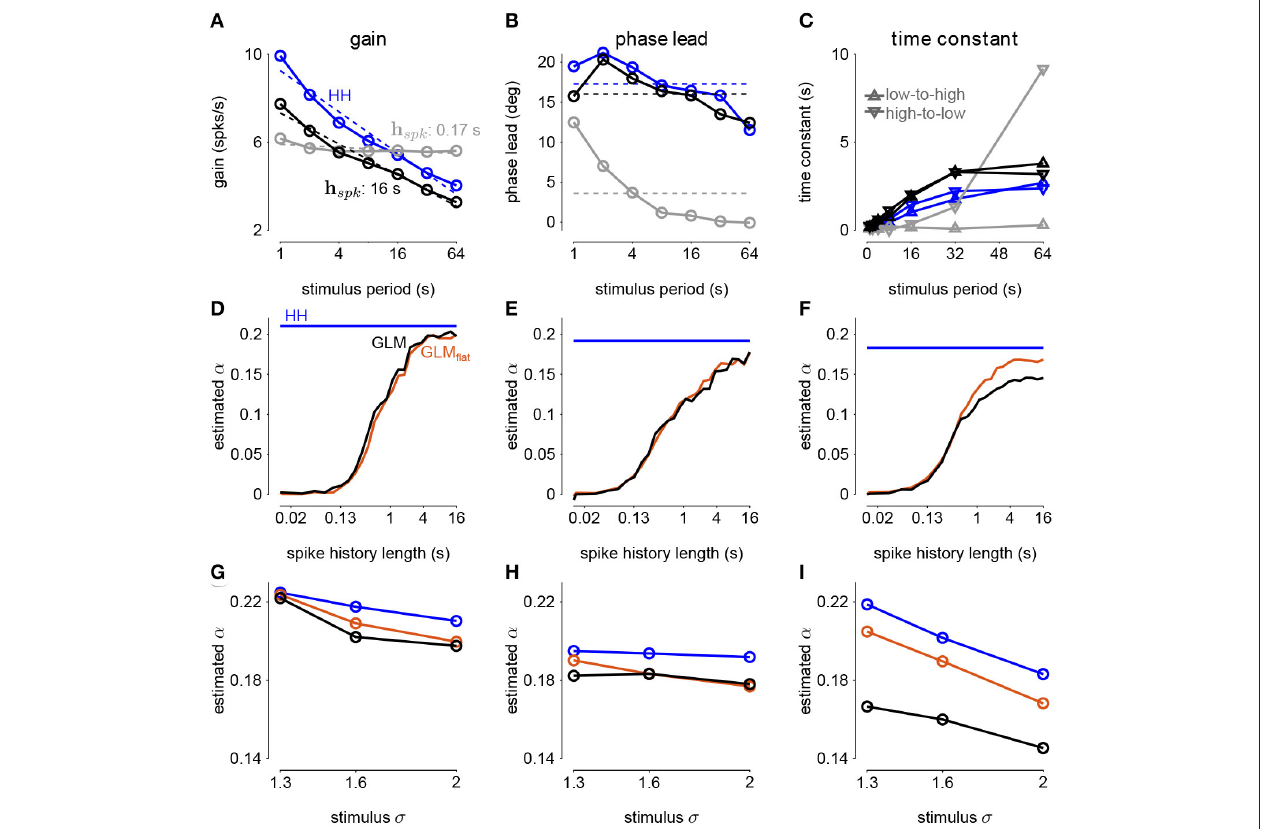
FIGURE 9 | (A) The gain of the average responses to sine-wave modulated noise as a function of stimulus period for the HH and GLMs ( Figures 8A,B right). The GLM fit with a 0.17 s spike history filter (gray) is compared to the GLM with the full 16 s spike history (black). The HH simulation is given in blue. The noise stimulus was modulated with σ = 2. (B) The phase lead of the average responses to sine-wave modulated noise as a function of stimulus period for the HH and GLMs. The fraction of variance explained in the HH phase lead curve by the GLM with 16 s spike history was R 2 = 0.61. (C) The time constant of an exponential function fit to the cycle-averaged response to square wave noise for each stimulus period ( Figures 8C,D right). The markers denote time constants estimated for steps from low to high variance or step from high to low variance. The fraction of variance explained of the log time constants of the HH simulation by the GLM with 16 s spike history was R 2 = 0.80. (D) The fractional differentiation order ( α ) of the GLM estimated by the slope of gain as a function of the log stimulus period in (B) . The value is estimated for each spike history lengths (black) and compared to α estimated from the HH simulation (blue). The red trace shows α estimated from the GLM fit only to unmodulated noise. (E) α estimated by the average phase lead across stimulus periods. (F) α estimated by fitting a the square-wave responses with a fractional differentiating filter. (G–I) α estimated at different noise modulation strengths for the 16 s spike history GLM and HH